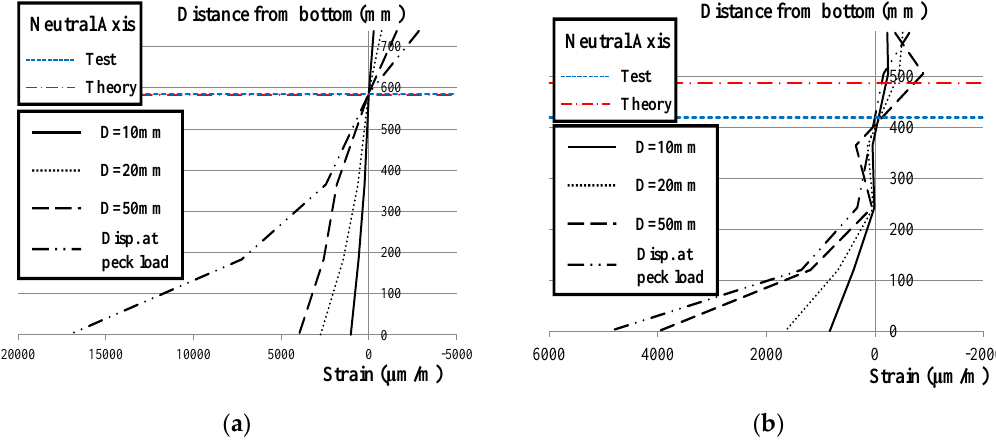
Figure 16. Ultimate failure modes of the fully composite specimens: ( a ) 738-WFC-X-X-TD; ( b ) 585-TFC-O-R1-DD. Table 13. Locations of neutral axis at failure of the fully composite specimens.